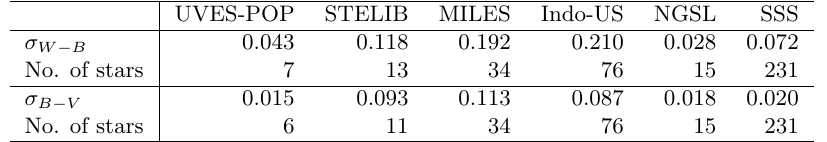
Table 3. Comparison of synthetic and catalogued (Kornilov et al. 1991)